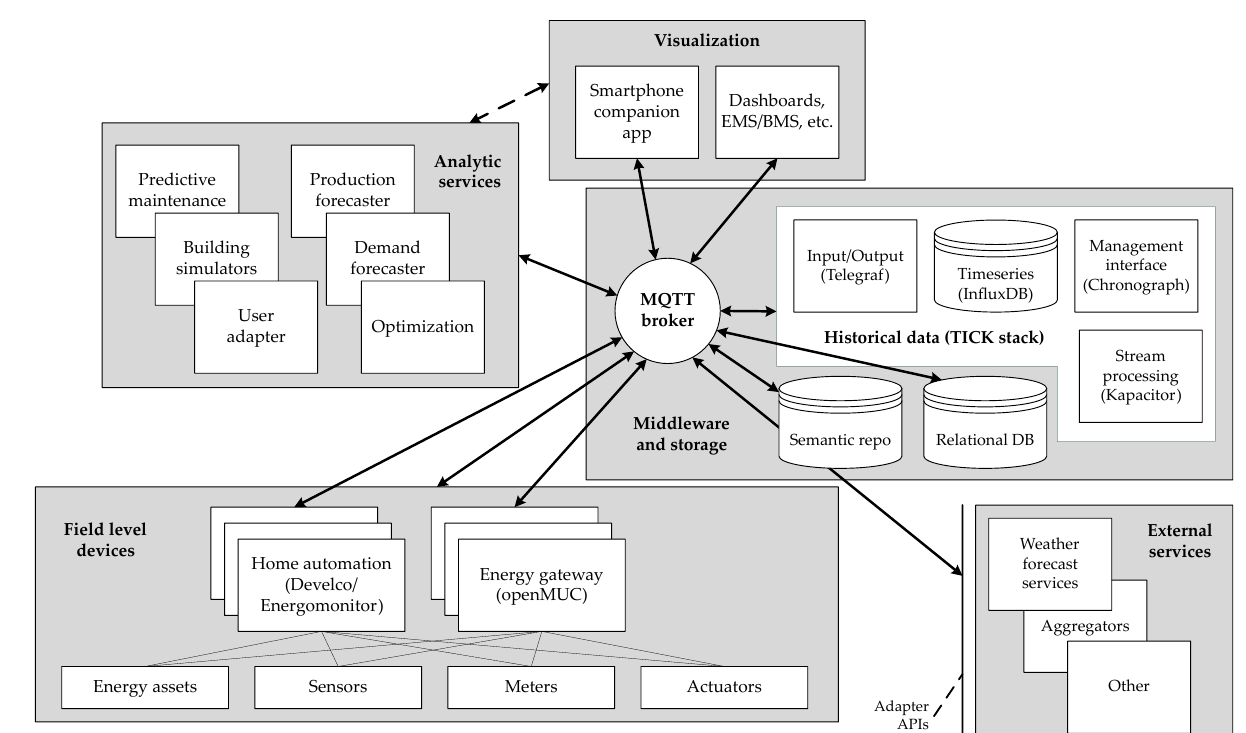
Figure 1. The RESPOND Internet of Things (IoT) platform architecture for acquiring, processing and exploiting